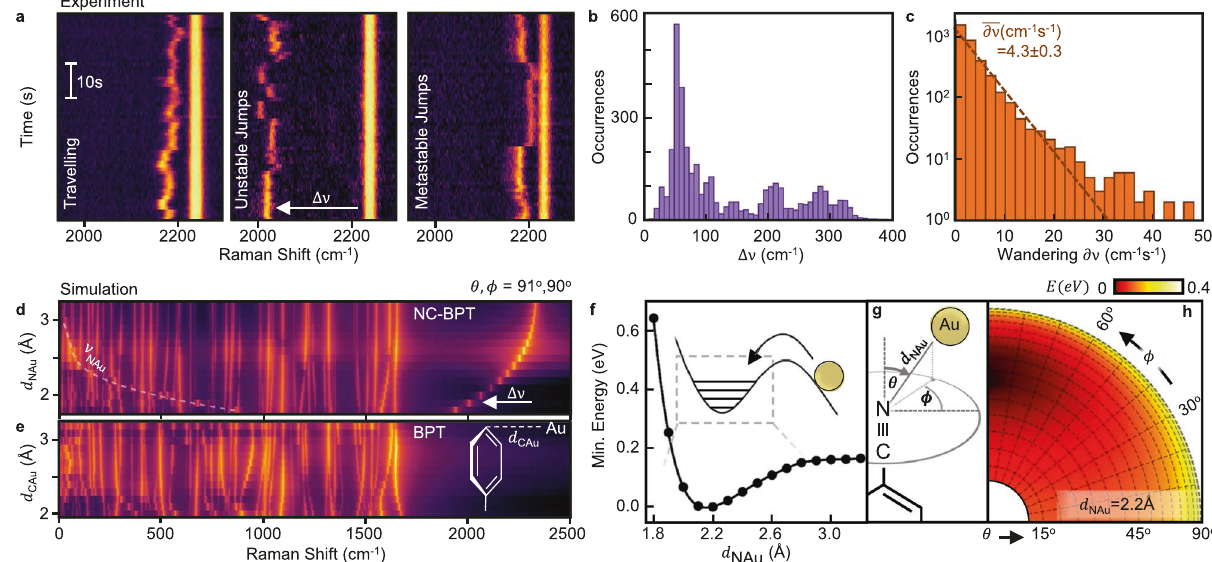
Fig. 2 Spectral perturbation varies with adatom position. a SERS spectra showing varying dynamical behaviour of the perturbed C ≡ N vibrational line ( Δ ν ) within the single molecule. b Histogram of experimentally observed CN downshifts in NC-BPT from unperturbed vibration energy. c Experimentally (cid:1) (cid:3) observed changes in CN vibration energies within 1s, fi t to likelihood of wandering / exp (cid:4) ∂ ν = 4 : 3cm (cid:4) 1 s (cid:4) 1 (dashed). d DFT Raman spectra of NC-BPT vs d fi xed ϕ = 90°, θ = 91° (de fi ned in ( g ), log colour scale). Virtual N − Au vibrational energy indicated by dashed line. e DFT Raman spectra of NAu at biphenyl-4-thiol (BPT) with adatom approach along energy minimising path (dashed) (log colour scale). f System energy vs d NAu , optimising adatom position angularly. g Coordinate system de fi ning adatom position relative to CN bond and upper ring of NC-BPT. h Relative system energy with varying adatom angular positions for energetically favourable d NAu = 2.2